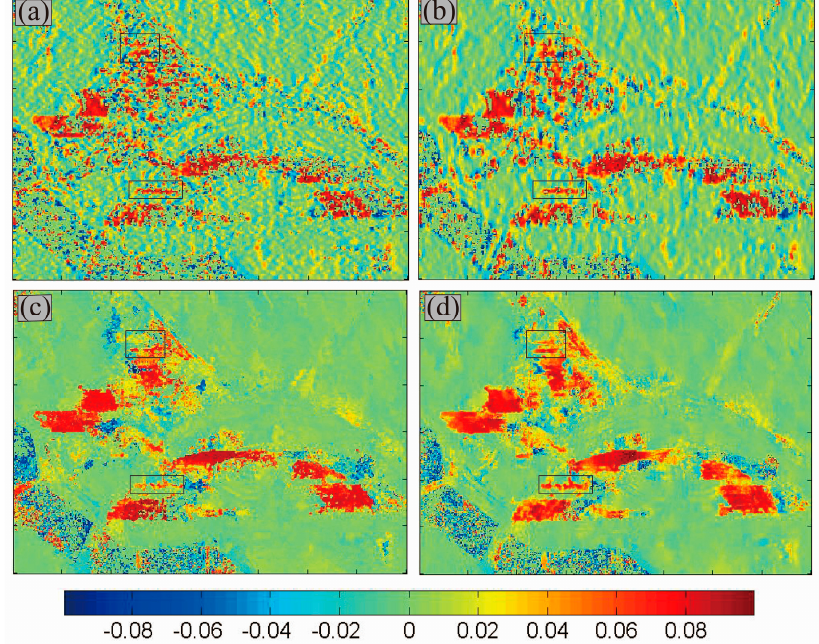
Figure 7. Result of local frequency estimation in the range direction after setting a threshold: ( a ) MLE with 3 × 7; ( b ) MLE with 7 × 7; ( c ) IDAN with 90 pixels; and ( d ) non-local with 90 pixels.